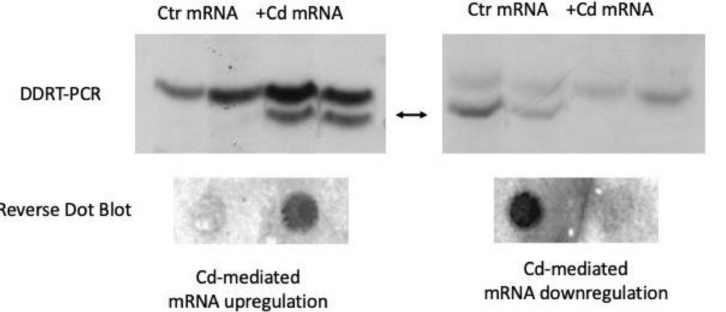
Figure 1. Representative identification of cadmium-responsive genes by using the mRNA differential display reverse transcriptase-polymerase chain reaction analysis (DDRT-PCR) performed on total RNAs extracted from control- (Ctr) and Cd-treated (+Cd) embryos incubated for 20 days after laying in Cd-contaminated soil. The result of such analysis was validated by subsequent reverse dot blot hybridization [8].